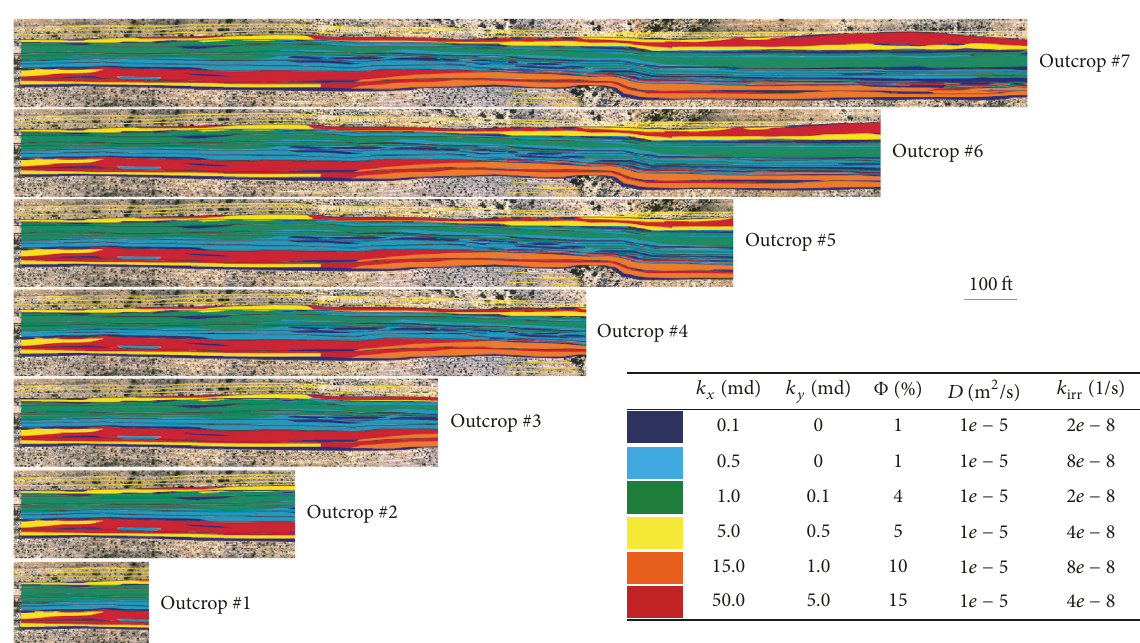
Figure 3: Seven images of the same outcrop with its increasing length at field scale. The outcrop comes from a carbonate field having heterogeneous physical and chemical properties [78,